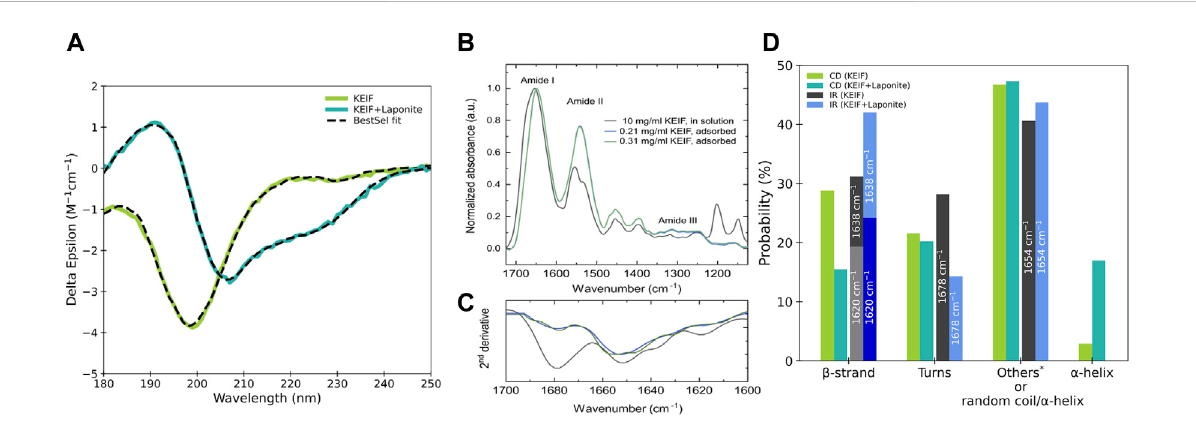
Experimental data of KEIF in solution and with Laponite ® . (A) SRCD data, (B) ATR-FTIR data, and (C) their second derivative analysis. (D) ProbabilityofsecondarystructureelementsforKEIFwasobtainedfromthe fi ttingbyBeStSel.StructureswithintheDSSPclassi fi cationundetermined by BeStSel fi tting of SRCD are included in “ others ” : 3 10 -helix, bends, and random